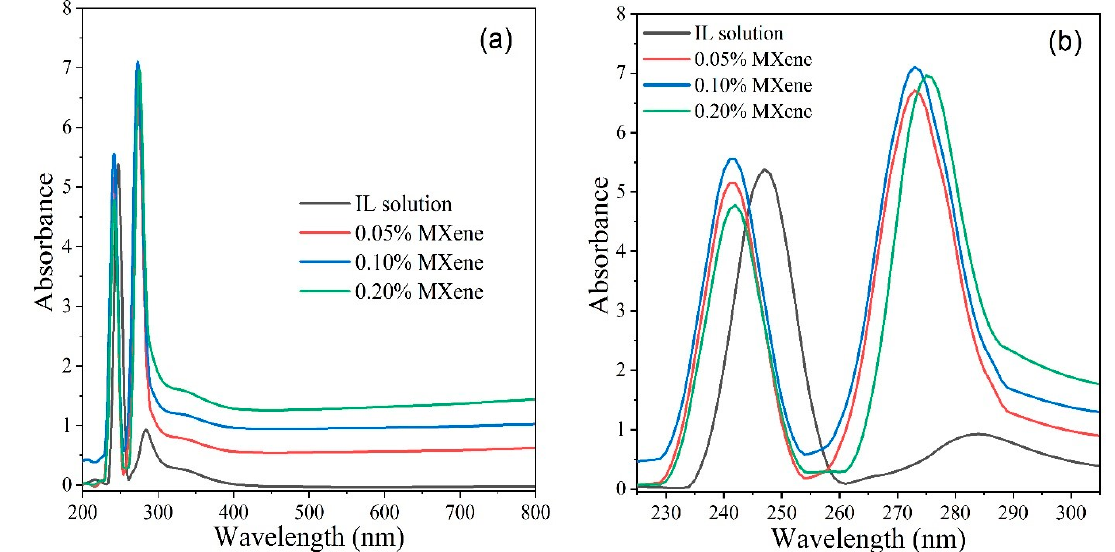
Figure 7. FTIR spectra of nanofluids at different concentrations.